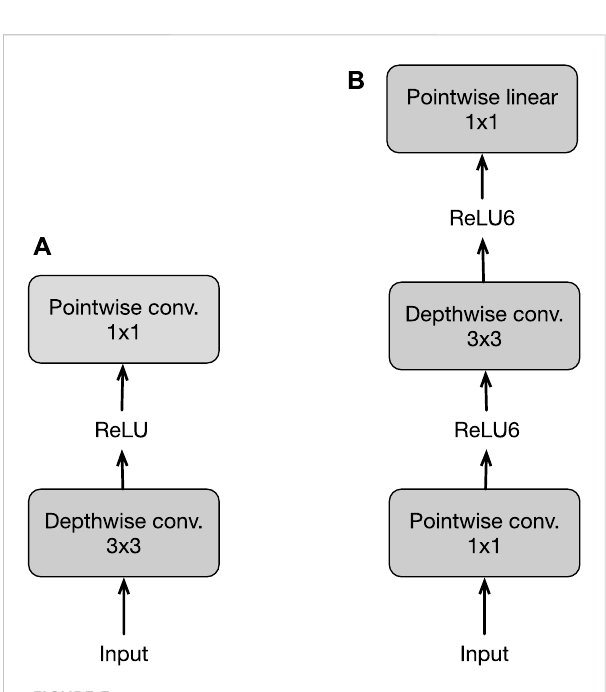
FIGURE 3 The MobileNetV1 (A) and MobileNetV2 (B) architectures: ReLU6 is used in MobileNetV2 instead of the standard ReLU.